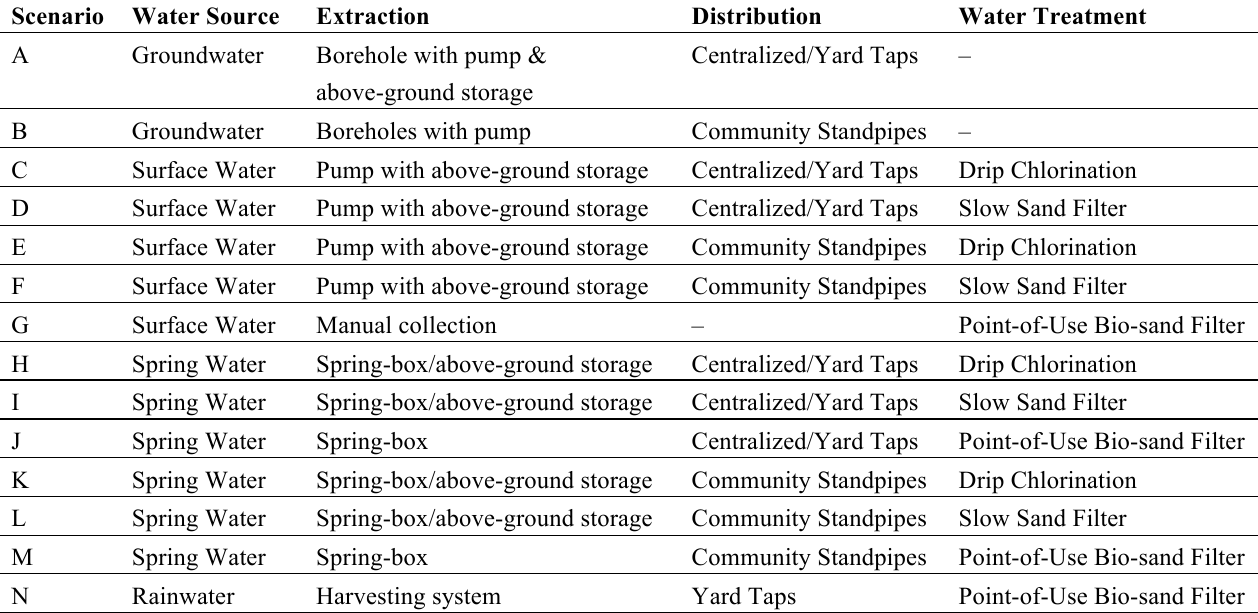
Table 2. Water system scenarios for rural communities in resource-limited